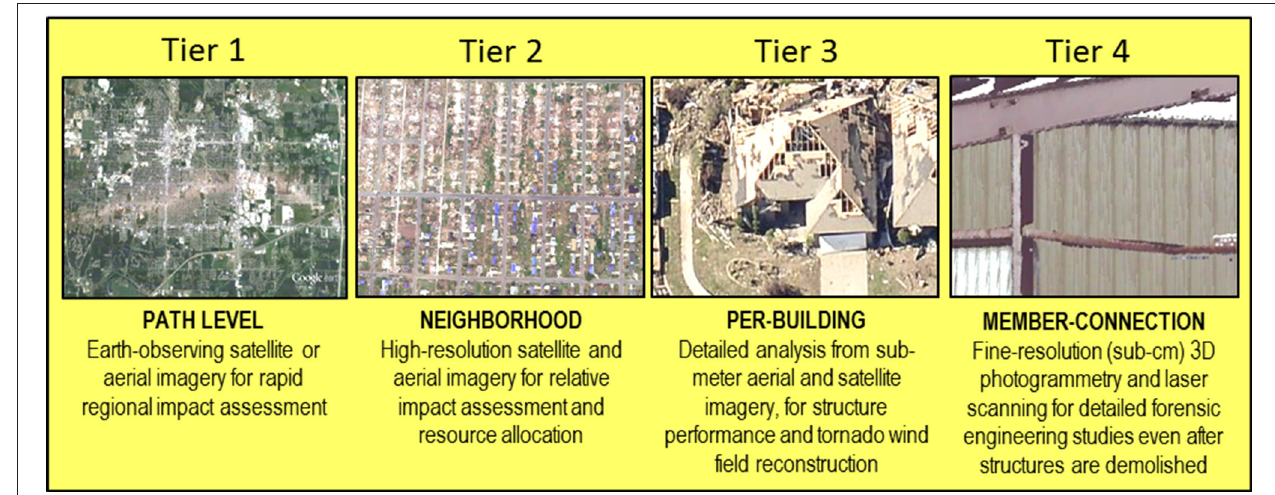
FIGURE 1 | Four distinct tiers for remote sensing of tornado effects at different spatial levels. Image credit: Google, NOAA (public domain), and